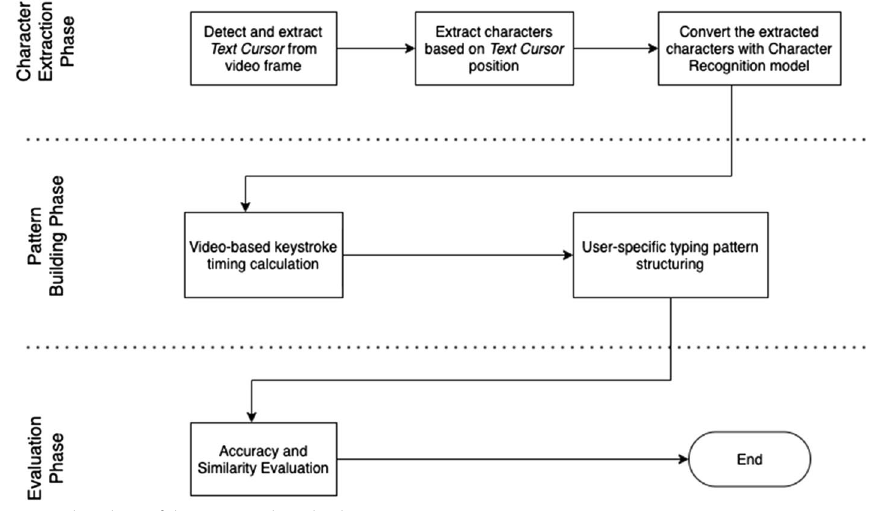
Fig. 2 Flowchart of the proposed